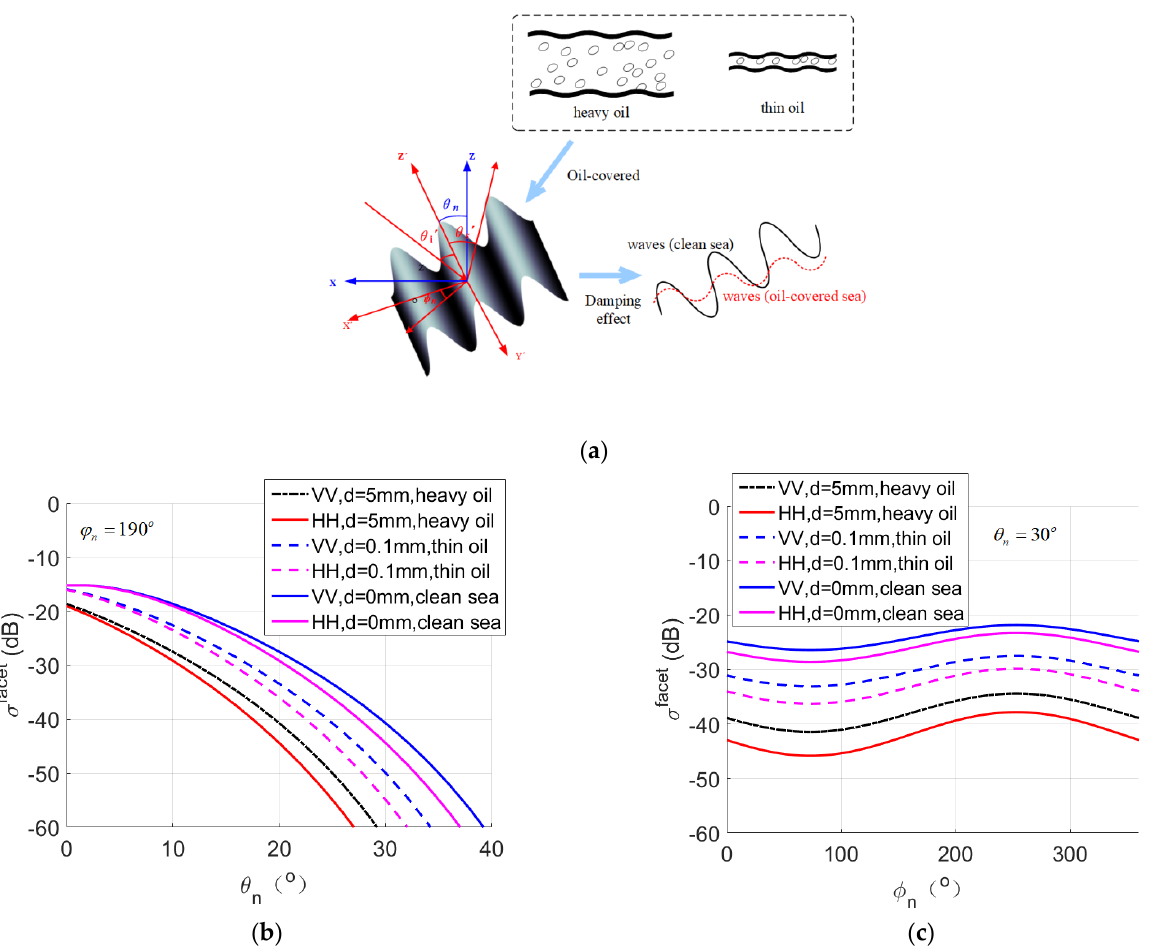
Figure 8. ( a ) The EM scattering simulation of grid elements in clean sea and oil spill–covered sea surface; ( b ) Influence of θ n on backscattering coefficient; ( c ) Influence of φ n on backscattering coefficient.